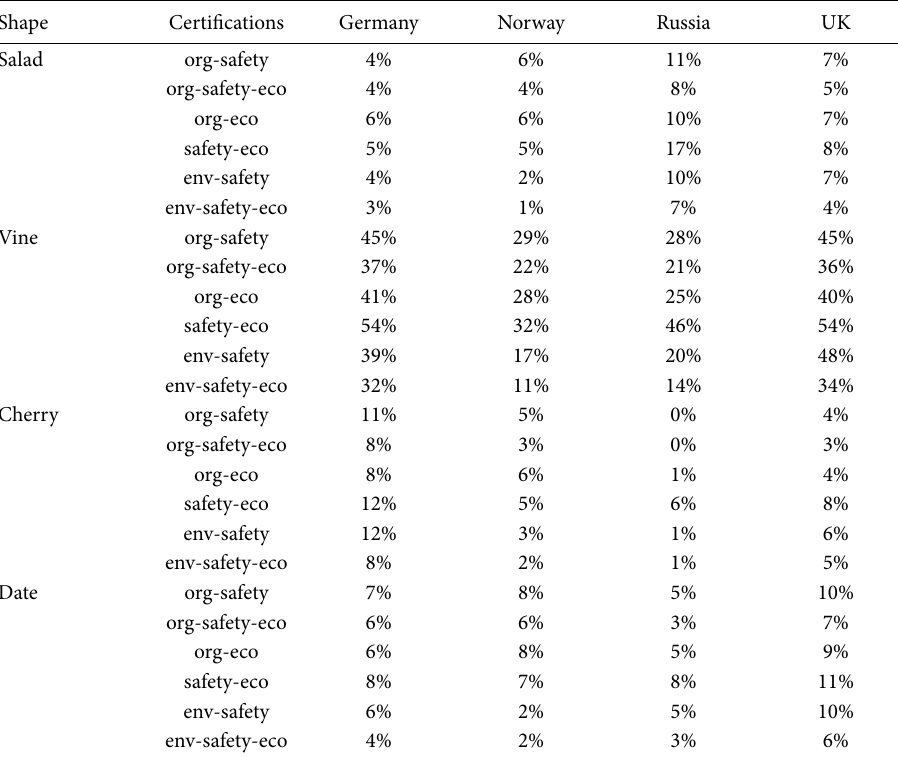
Table 5. Market shares for combinations of tomato shapes and certifications. Shape Certifications Salad